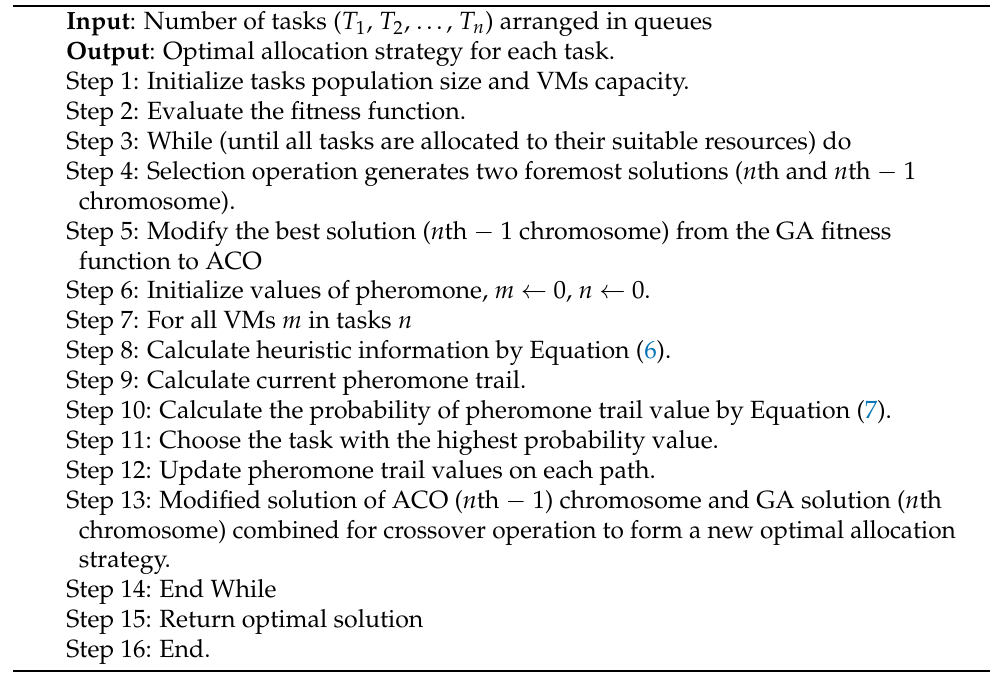
Algorithm 1: Adaptive Load Balancing Task Scheduling (ALTS) Algorithm